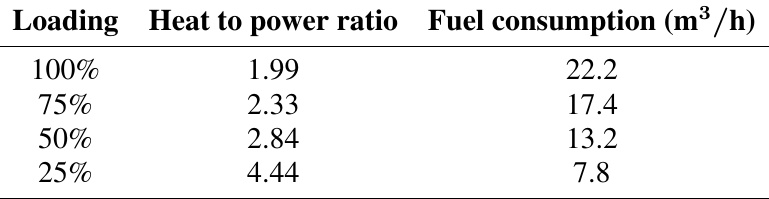
Table 3. Operation data of a C60 micro-CHP plant from Capstone [36].